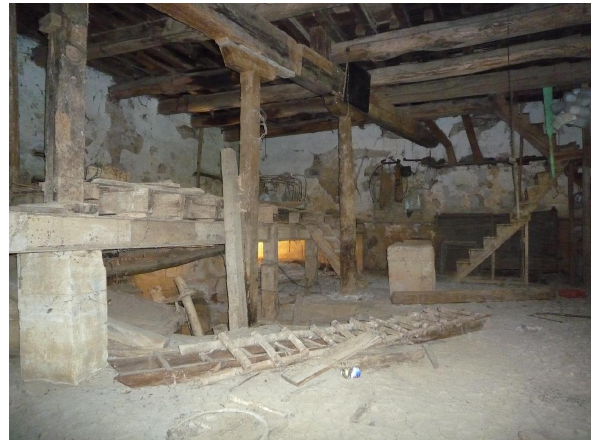
Figure 8: Current state of indoor scenario